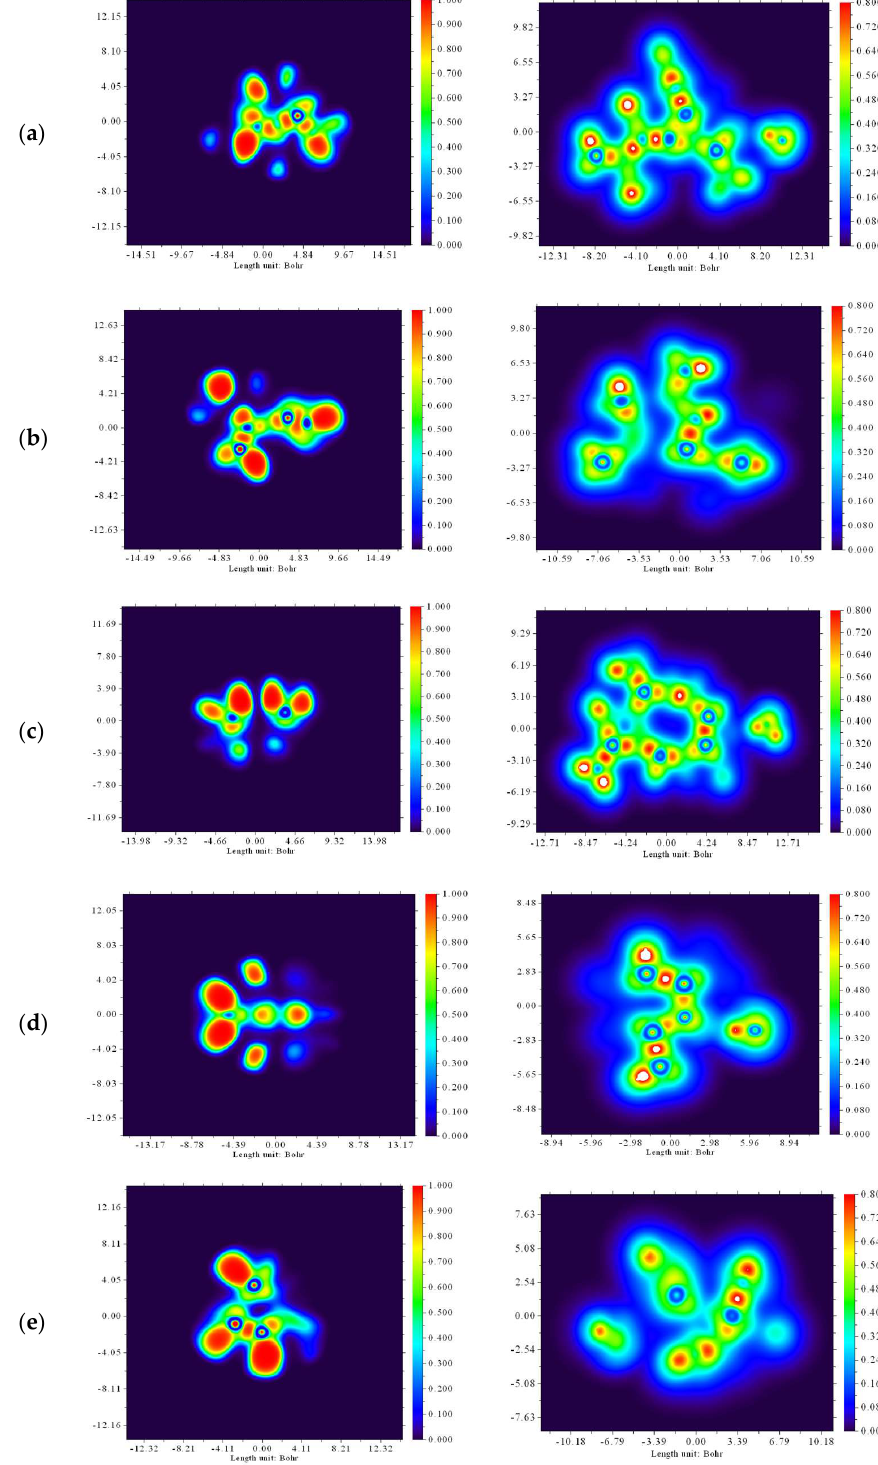
Figure 5. Electron localization function (ELF) maps ( left ) and localized orbital locator (LOL) maps ( right ) of the binary mixtures ( α -cubebene–water ( a ), β -caryophyllene–water ( b ), caryophyllene oxide–water ( c ), 1,8-cineole–water ( d ), and β -pinene–water ( e